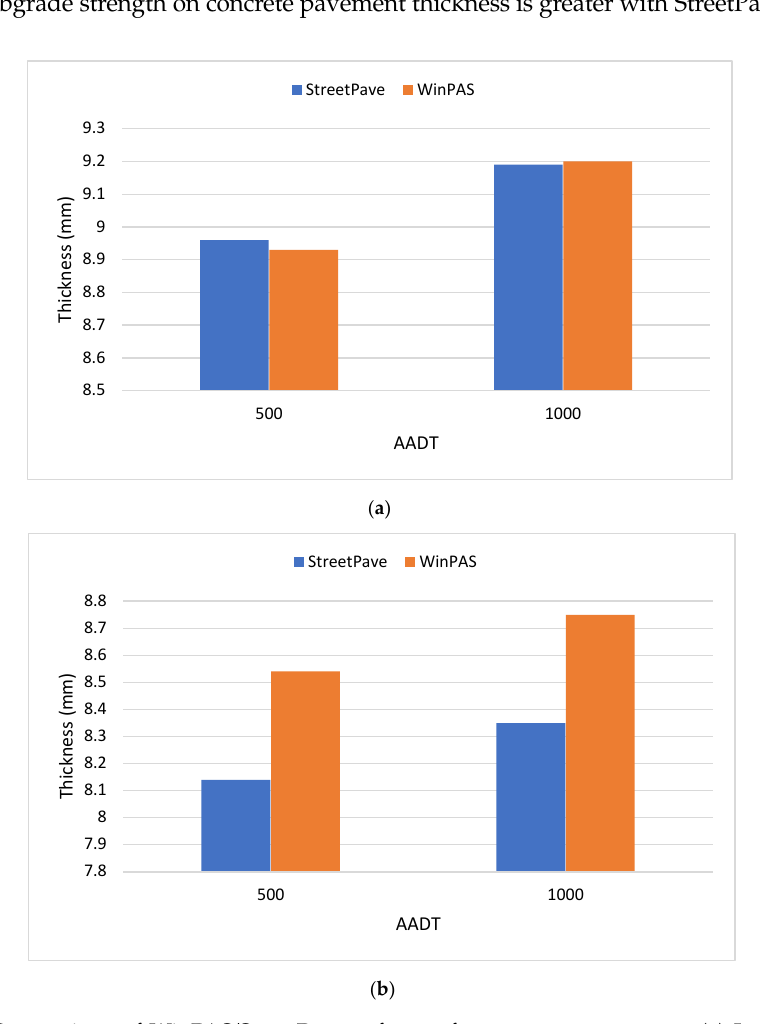
Figure 2. Comparison of WinPAS/StreetPave software for concrete pavement. ( a ) Low subgrade strength. ( b ) High subgrade strength.